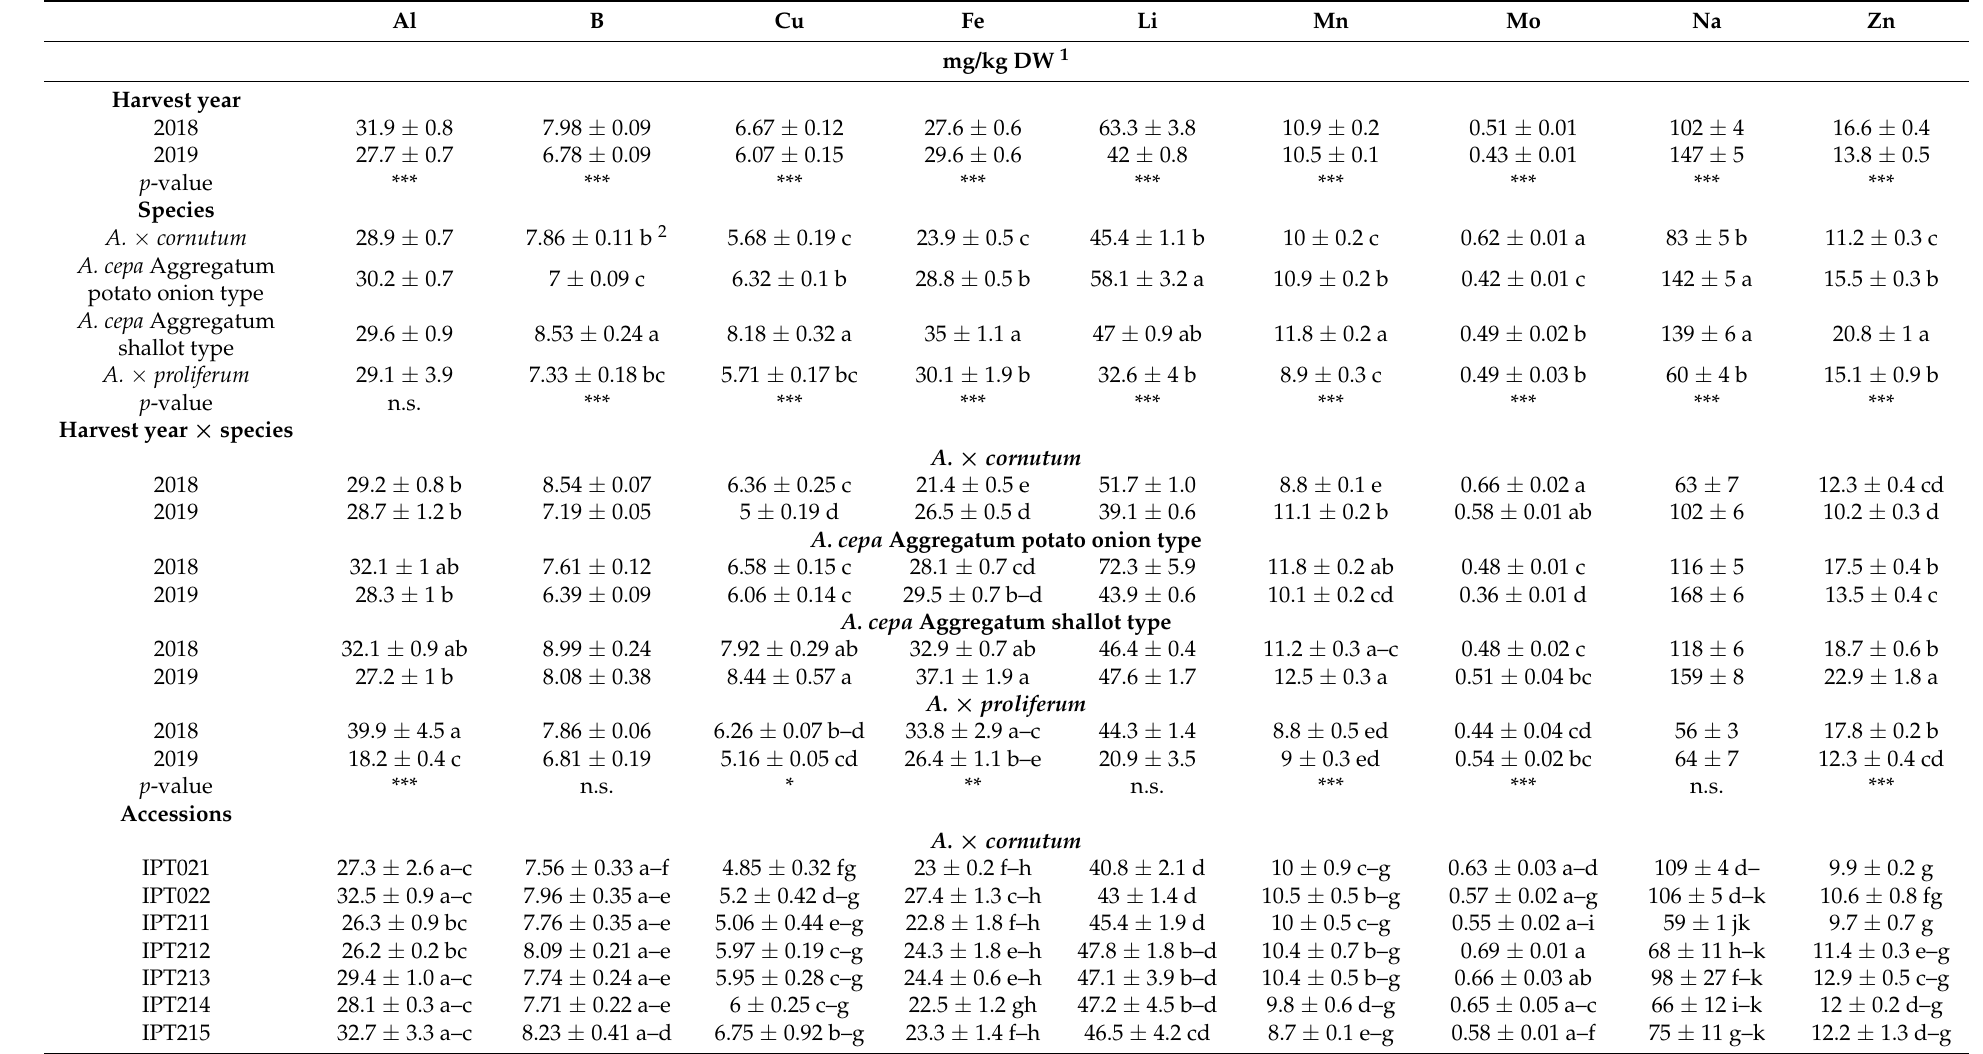
Table 4. Shallot micro-element composition by harvest year and species, their interaction and individual